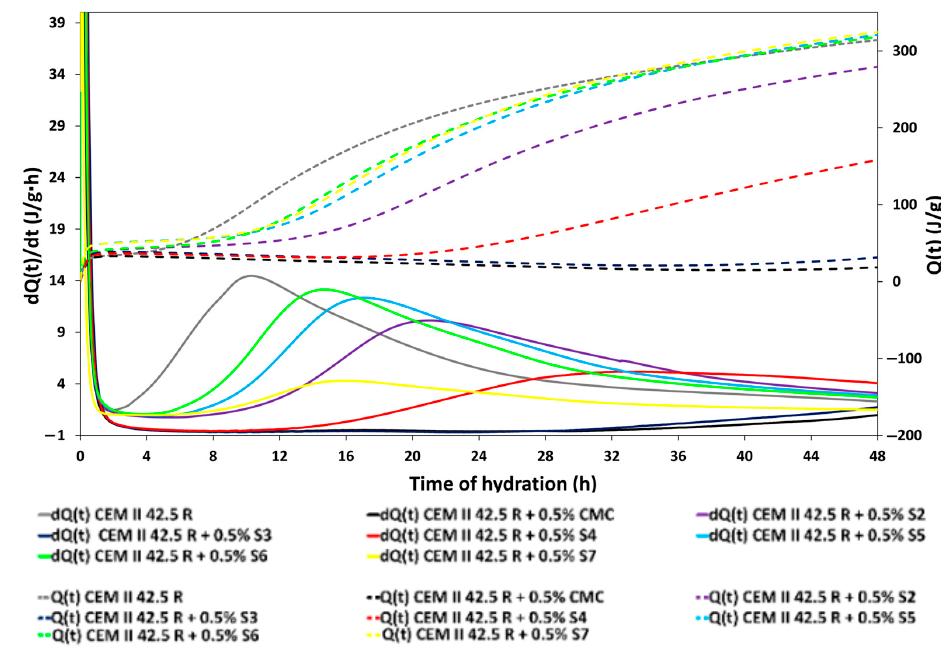
Figure 5. Influence of the cellulose-based superplasticizer investigated with a w/c ratio = 0.5 on the early age hydration of CEM II 42.5 R by calorimetric studies.